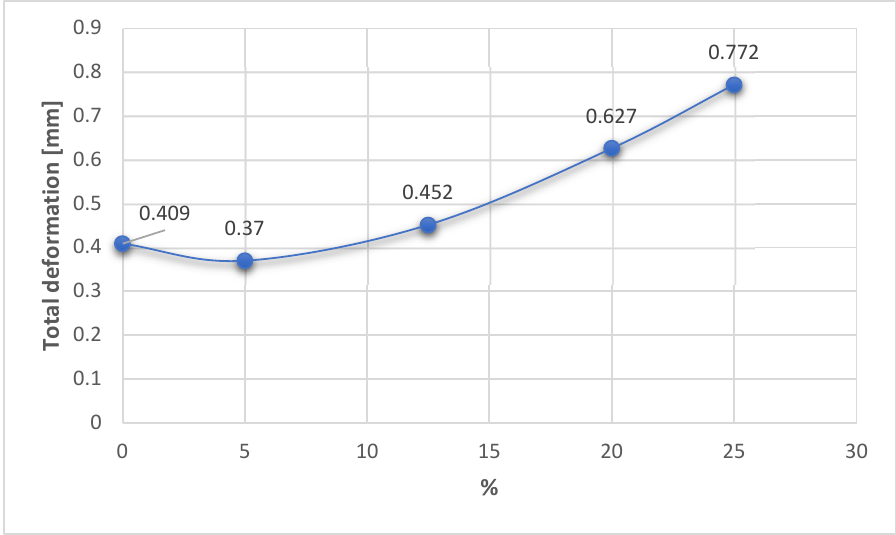
Figure 15. Distributions of the total deformation, equivalent stress in tibia and equivalent stress in the plate—25%.